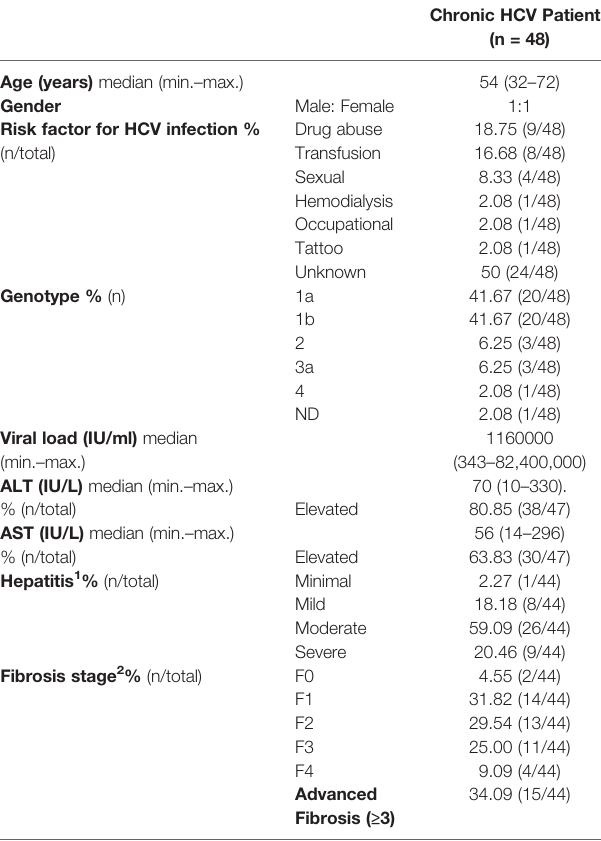
Chronic HCV Patients (n = 48)